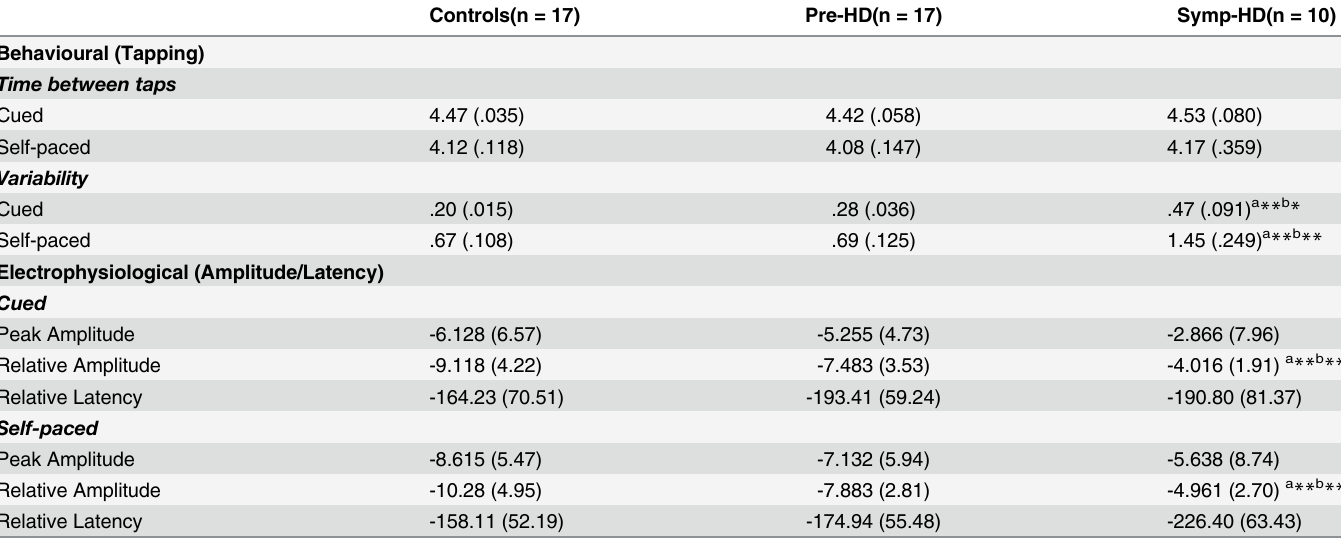
Table 2. Electrophysiological and behavioural results for participants in the Tapping Task 1 (cued and self-paced Conditions). Amplitude and latency by at Cz, averaged across groups. Standard deviations (SD) provided in